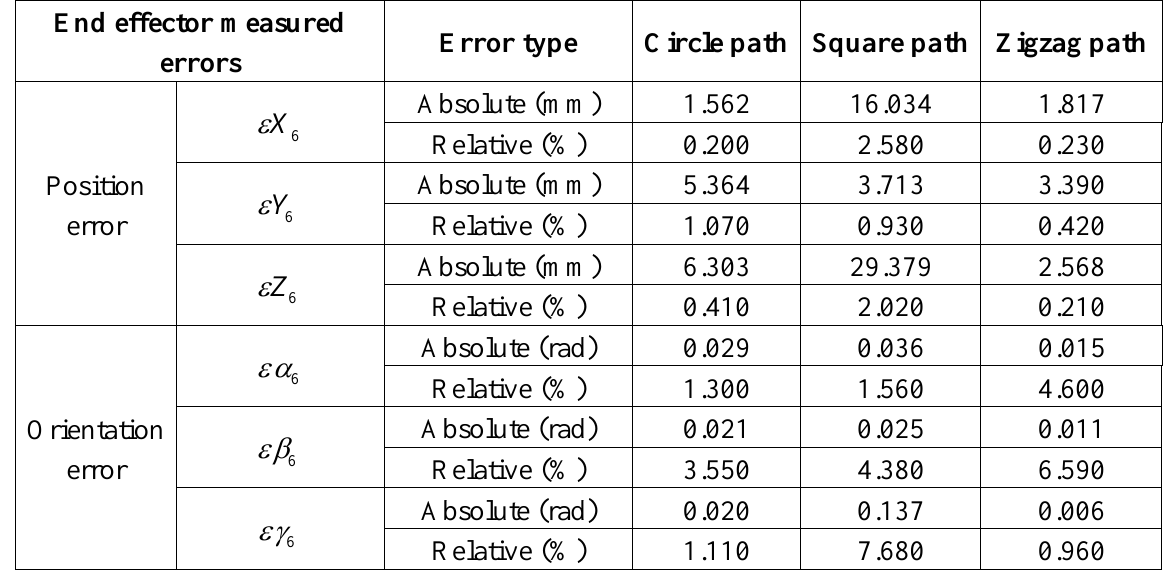
Table 5. End effector measured errors in position and orientation for both circle and square